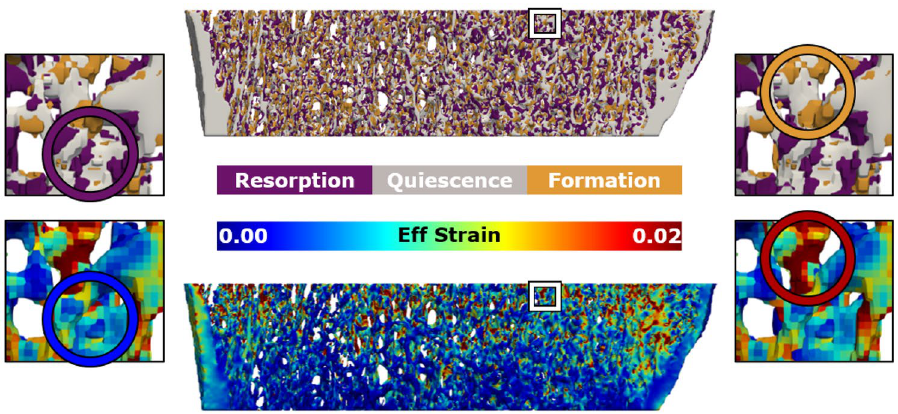
Figure 4. 3D reconstruction of remodeling (top) and effective (Eff) strain (bottom) for a representative participant highlighting the prominence of resorption in areas of low effective strain (left) and formation in areas of higher effective strain